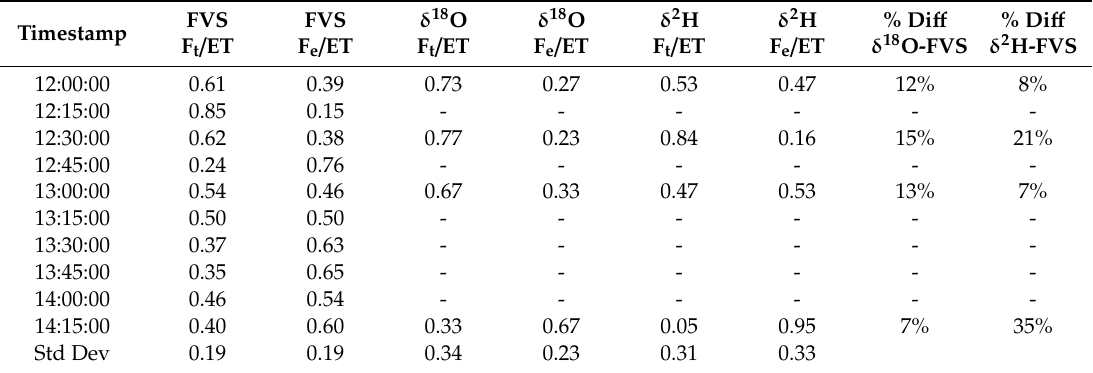
Table 5. Comparison of ET partitions created from the Flux Variance Similarity (FVS) and IMB methods and the di ff erences between the